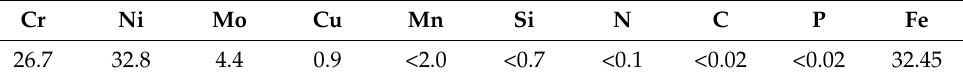
Table 1. Elemental composition of the UNS N08029 alloy (in wt.%).